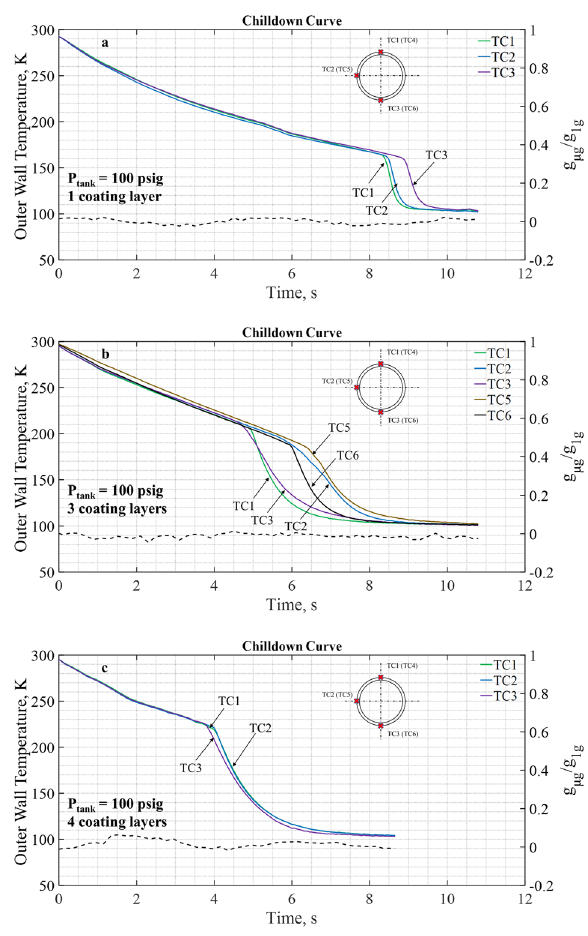
Fig. 4 Chilldown curves for test tubes with different thicknesses of coating layers. On each fi gure there are three chilldown curves generated with data collected from the three TCs (located at top, side, and bottom) with all at the upstream TC station under the same inlet pressure of 100 psig. a Test tube with one coating layer, b test tube with three coating layers, and c test tube with four coating layers. The chilldown curve of the bare tube surface case is given in Fig.